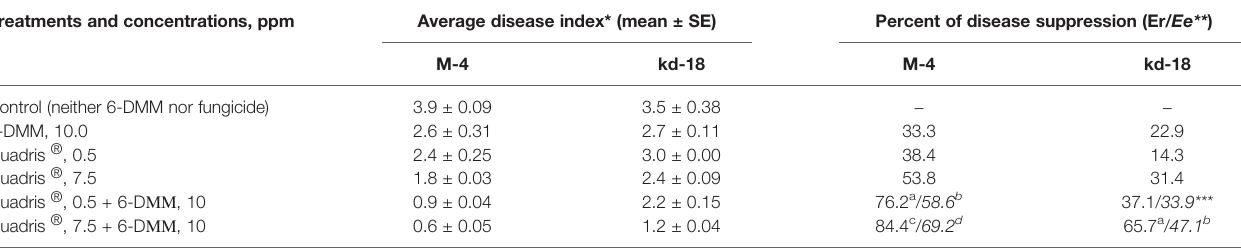
TABLE 3 | In fl uence of Quadris ® SC 250, 6-DMM or their combinations on the disease severity on detached wheat leaves infected with P. nodorum wild strain (M-4) or azoxystrobin-resistant mutant (kd-18). Treatments and concentrations, ppm Average disease index* (mean ±